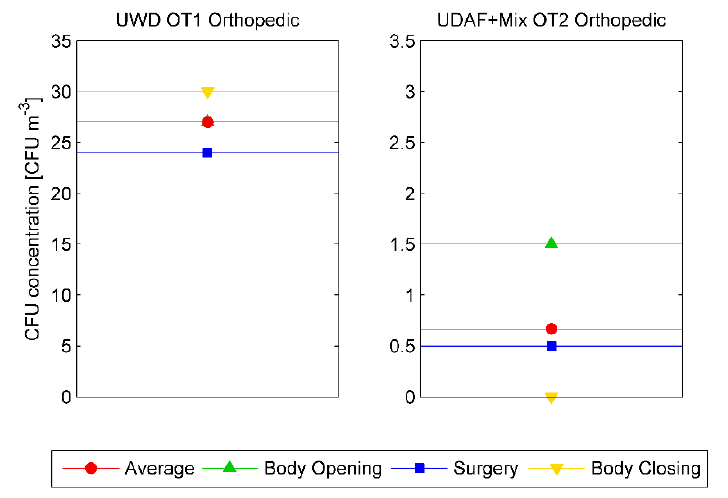
Figure 5. Time average CFU / m 3 values for UWD OT1 (left) and Hybrid OT2 (right) in orthopedic surgeries as function of surgery phases.